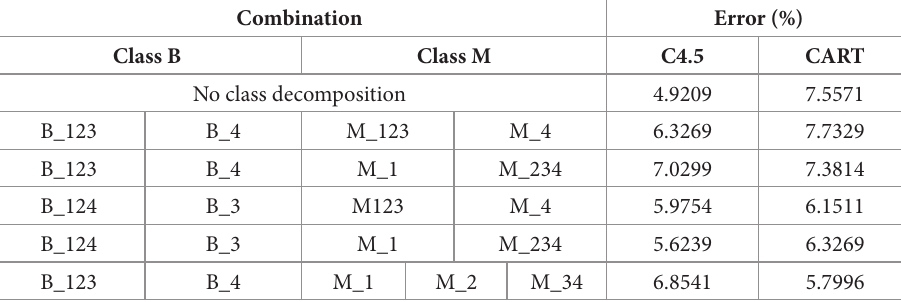
Table 6. Classification errors of decomposed classes transformed for existing